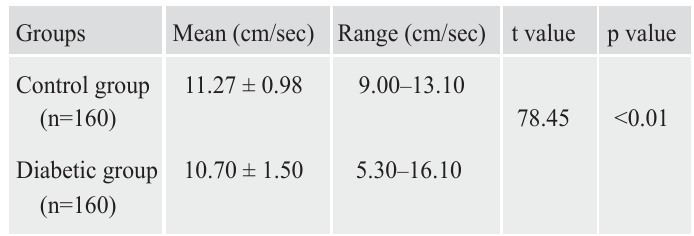
Table II: Comparison between mean end diastolic velocity of